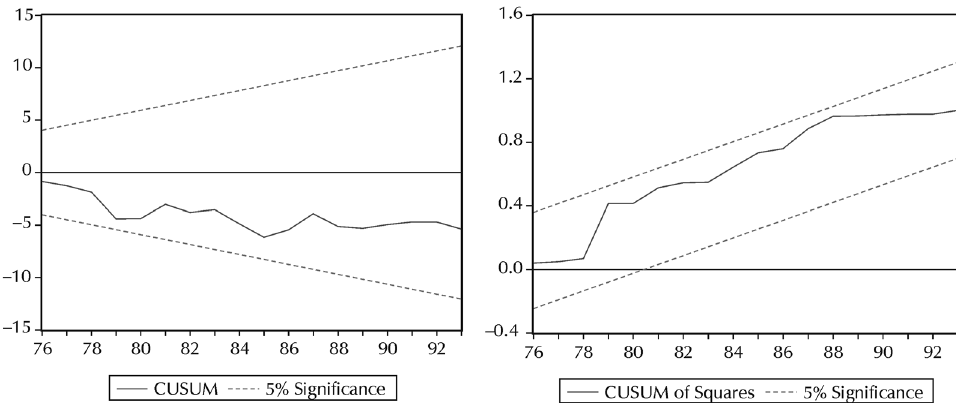
Recursive Residuals Tests for exchange market